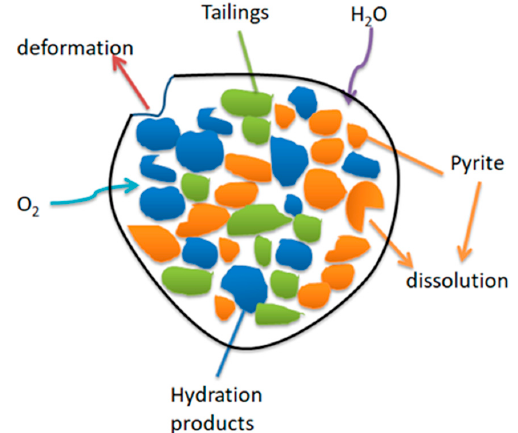
Figure 13. Failure of cemented sulfur tailings backfill skeleton [37].